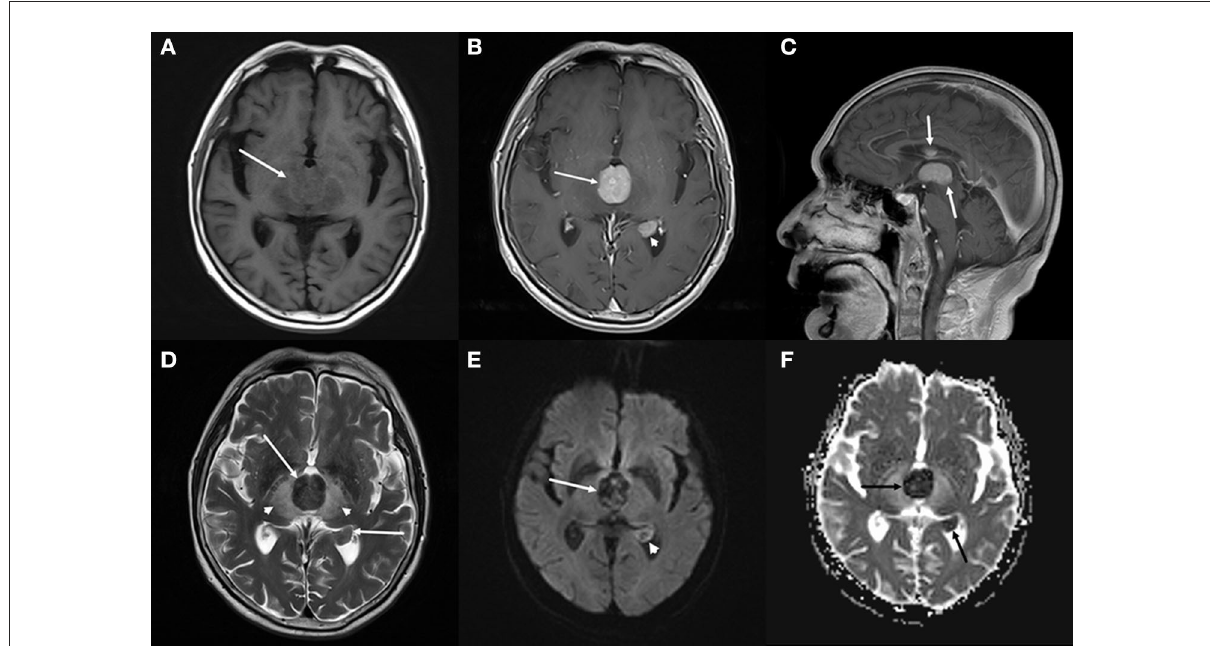
FIGURE2 Brain magnetic resonance imaging (MRI). (A–C) Axial T1-weighted imaging (T1WI) (A) shows that the masses with slight hypointensity are in the third ventricle (arrow) and the posterior horn of the left lateral ventricle. Both of them are significantly enhanced on axial (B) and sagittal (C) T1WI with contrast. (D–F) T2-weighted imaging (T2WI) (D) shows the isointense to slightly hypointense masses (arrows), the swollen and hyperintense parenchyma around the third ventricle (arrowheads). Diffusion-weighted imaging (DWI) (E) shows a hypointense mass in the third ventricle (arrow) and a slightly hyperintense mass in the lateral ventricle (arrowhead), both of them with low apparent diffusion coefficient (ADC) value (ADC value: 0.425 × 10 3 mm 2 /s, 0.628 × 10 3 mm 2 /s) ( F , arrow), all suggesting diffusion restricted.